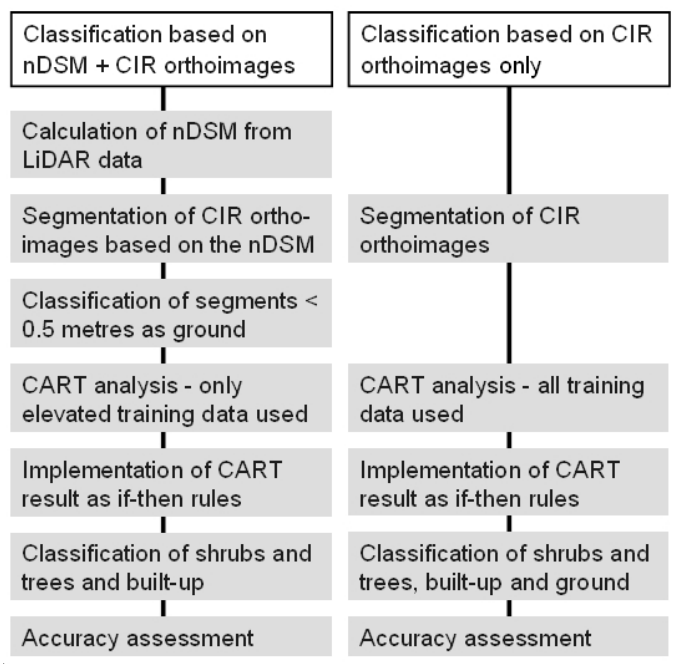
Figure 3. Overview of the